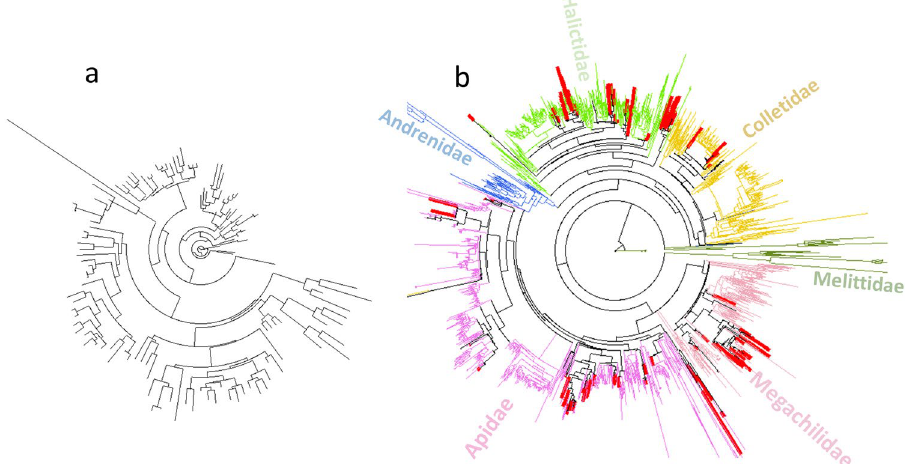
Figure 7. ( a ) Phylogeny only of the 128 OTUs generated in the current study. ( b ) Phylogeny of OTUs as in ( a ), except also including mined reference data, constrained to a published bee tree-of-life. OTUs from bees of NRWNNR sampled herein are indicated in red, six families of the mined reference data are otherwise coloured. Community diversity of habitat subsets of OTUs was calculated in the context of ( a ) and ( b